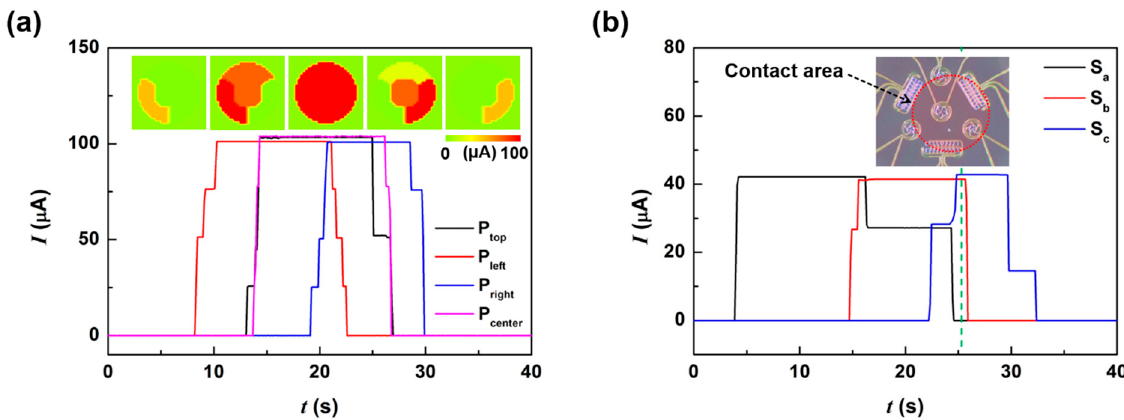
Figure 7. The output characteristic of the TIS depending on the sliding motion of a silicone sphere: ( a ) the measurement output of pressure sensor units, where the inset shows the variation in the current contour maps; ( b ) the measurement output of shear sensor units, where the inset shows the predicted contact shape at ~23 s (green dash line). These real-time measurement results are also shown in video